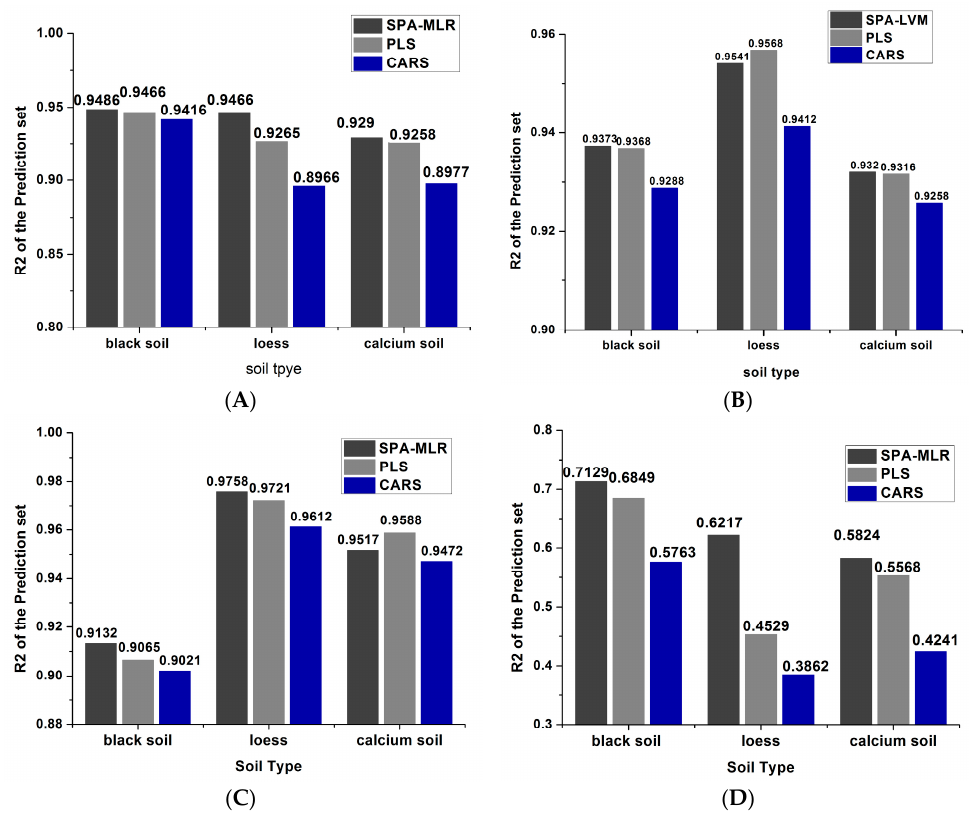
Figure 8. The prediction results of three kinds of soils at different drying temperatures based on three algorithms: ( A ) 50 °C drying; ( B ) 80 °C drying; ( C ) 95 °C drying; ( D ) 25 °C placement.